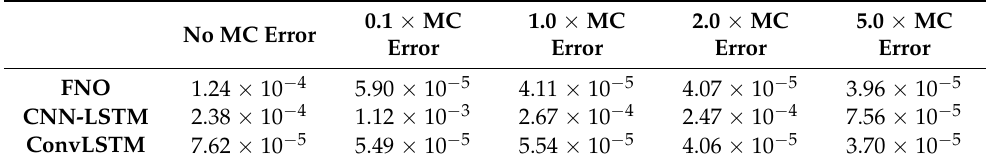
all optimized model architectures after a maximum of 300